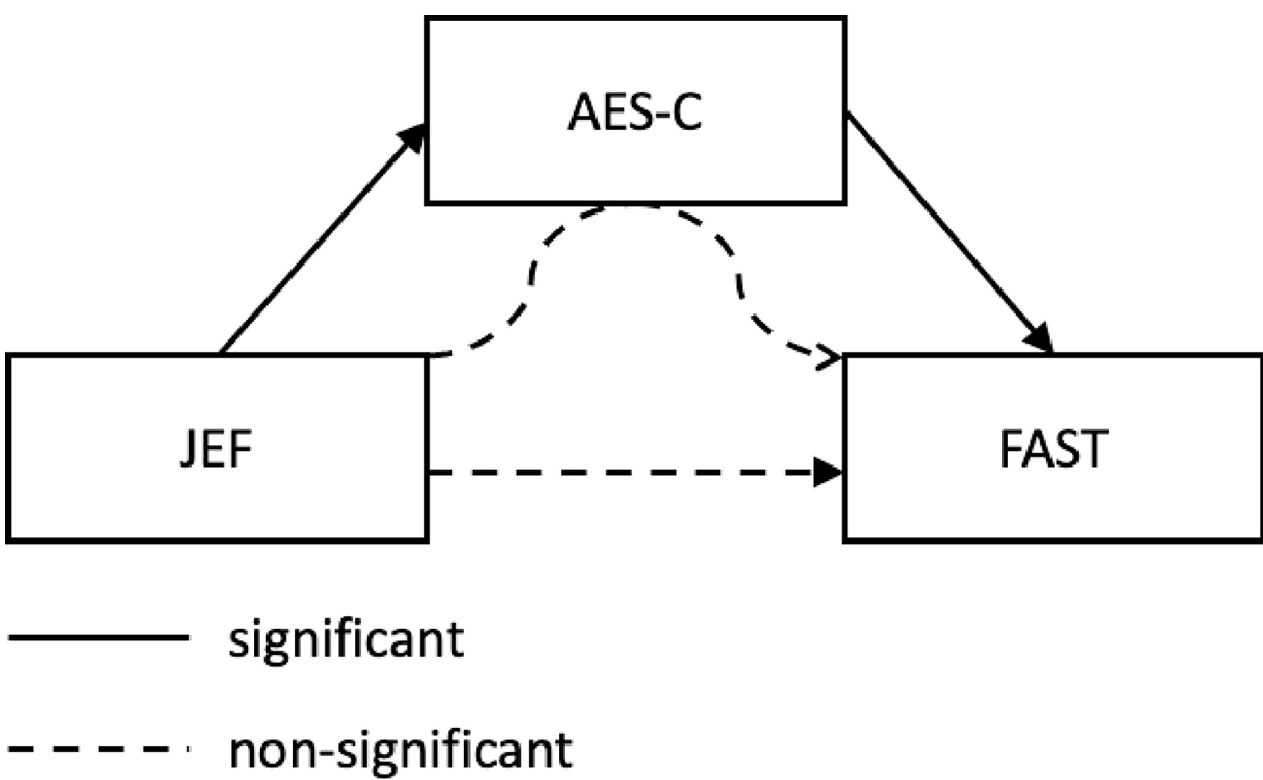
Fig 1. Cross-sectional mediation pathway between the predictor (cognition), mediator (apathy) and outcome (functional outcome). Black arrows indicate significant association while dotted arrows indicate no significant association. The outer straight arrows indicate direct effects, the curved inner arrow the indirect, mediating effect.